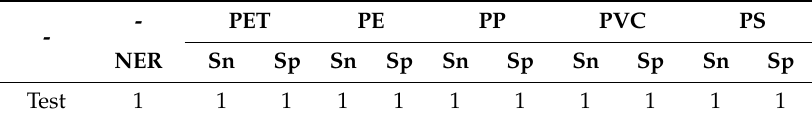
Table 4. Classification parameters (non-error rate (NER), class sensitivity (Sn), and specificity (Sp)) calculated on the validation